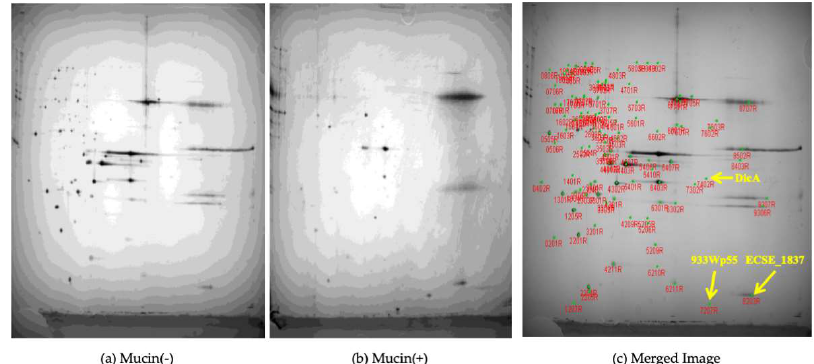
Figure 1. Changes in the extracellular secretion of Escherichia coli EDL933 proteins after mucin exposure, as detected by 2D gel electrophoresis: Secreted proteins in the absence ( a ) and presence ( b ) of mucin. ( c ) Merged image of ( a ) and ( b ). Three proteins, 933Wp55 [24], DiCA [25], and ECSE_1837 [26], which were identified in the presence of mucin are highlighted in yellow letters.